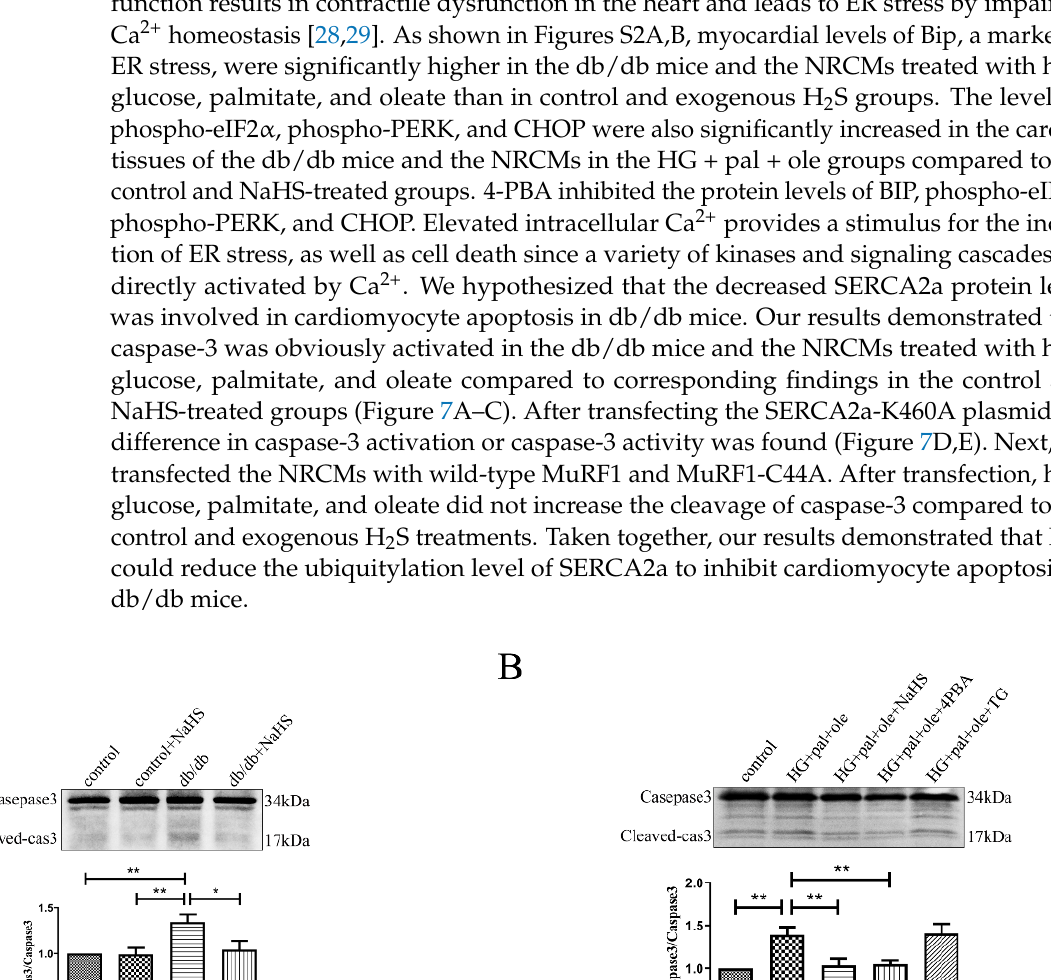
Figure 7. Mutation of SERCA2a Lys460 site reduces the level of apoptosis. ( A ) The expression of apoptotic marker cleave-caspase3 in cardiac tissues was tested by Western blotting ( n = 7). ( B ) The expression of cleave-caspase3 in the NRCMs by Western blotting ( n = 6). ( C ) The activity of Caspase3 in the NRCMs ( n = 4). The NRCMs were transfected with plasmids containing wild-type SERCA2a